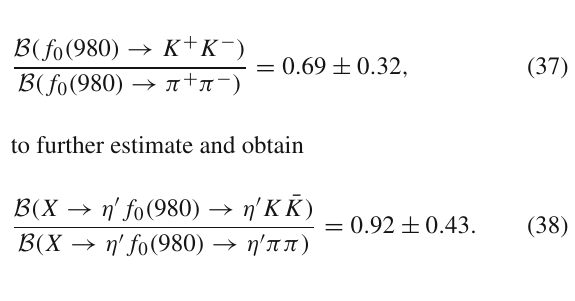
As shown in Fig. 5 using the dashed curve, the new ratio ) 2 /(Π Π ) is significantly suppressed in the (Π J 1 J 2 J 1 J 1 J 2 J 2 < 1 . 52 GeV 2 (Borel window for region 1 . 38 GeV 2 < M 2 B J 2 when setting s 0 = 7 . 6 GeV 2 ), so J 1 and J 2 only weakly correlate with each other inside this